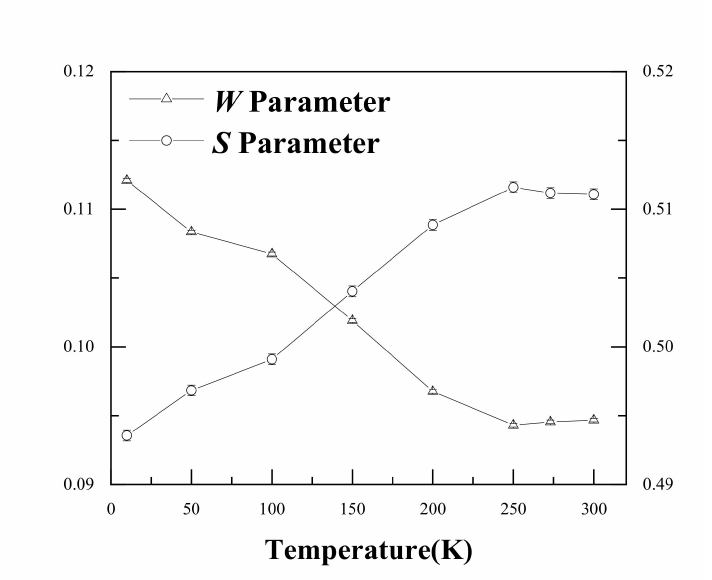
Figure 3. S and W values for the Al-0.2% Ag alloys at different measurement